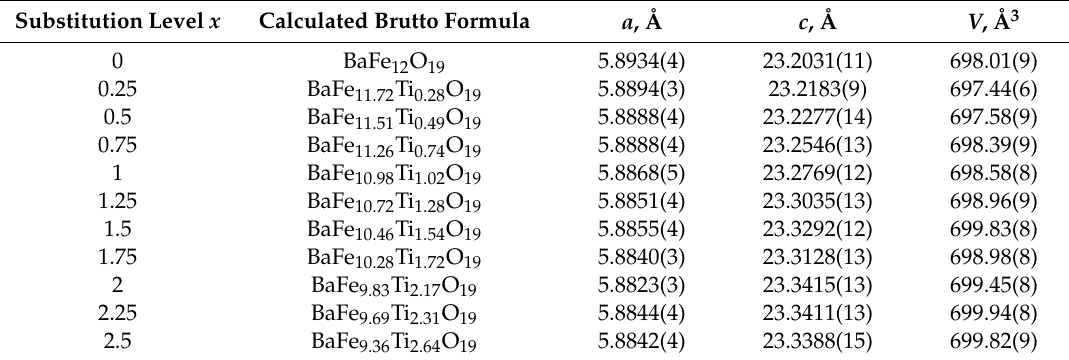
Figure 2. X-ray patterns for BaFe 12 − x Ti x O 19 , with x from 0 to 2.5. Table 1. Lattice parameters a and c and cell volume V for BaFe 12 − x Ti x O 19